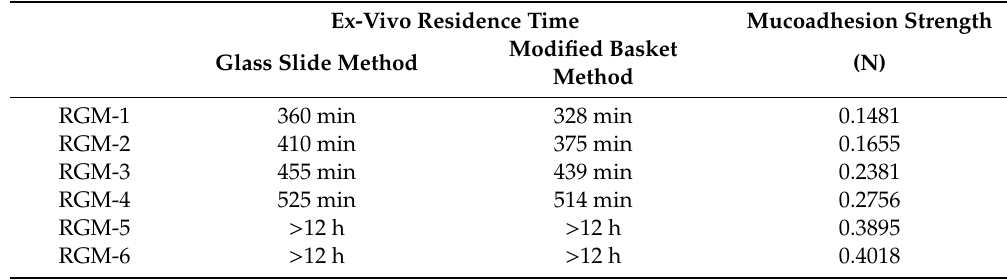
Table 2. Comparison of ex-vivo mucoadhesion time and mucoadhesion strength.